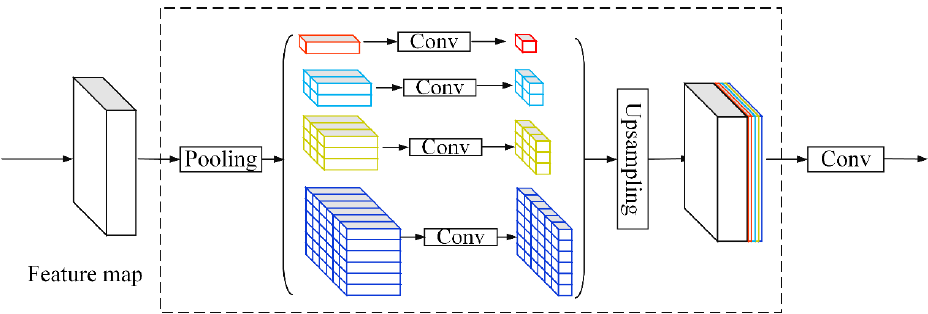
Figure 5. Structure of pyramid pooling module.